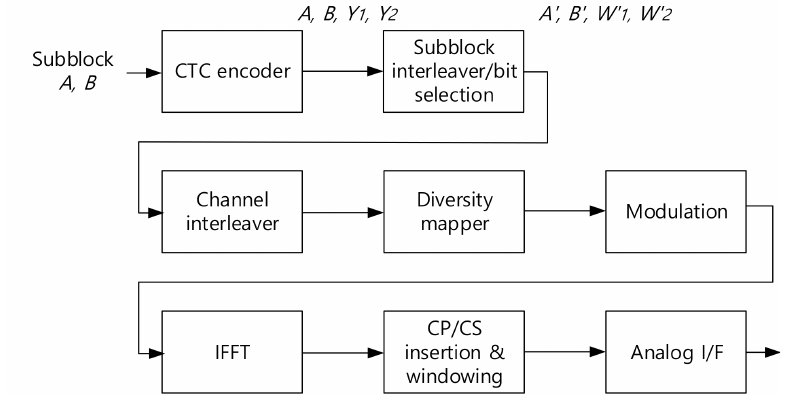
Figure 1. Block diagram of IoT PLC.